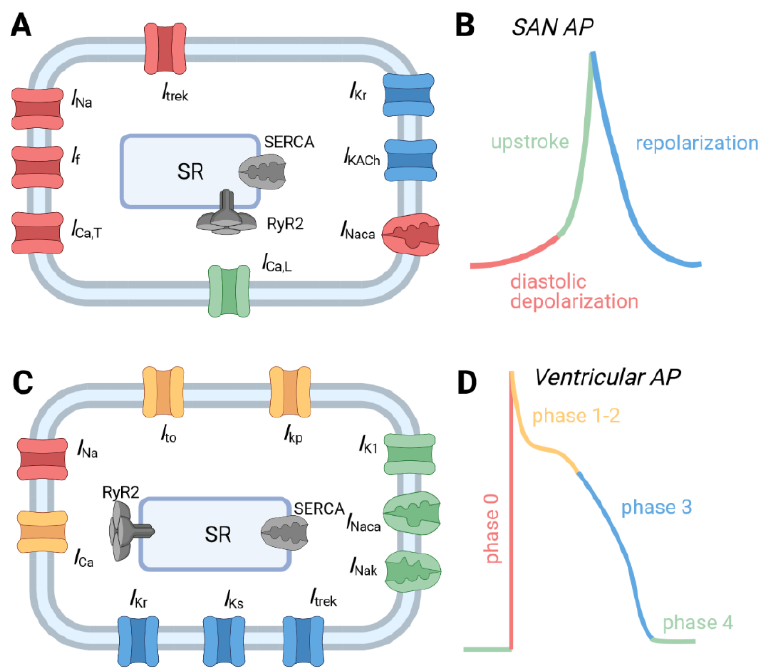
Figure 1. Major ion channels underlying the action potential from different regions of the cardiac conduction system. ( A ) Schematic of major ion channels and representative action potentials from ( A , B ) sinoatrial node and ( C , D ) ventricular myocytes. Channels are color coded to correspond to phase of the AP where they make an important contribution. Abbreviations are as follows: Acetyl-